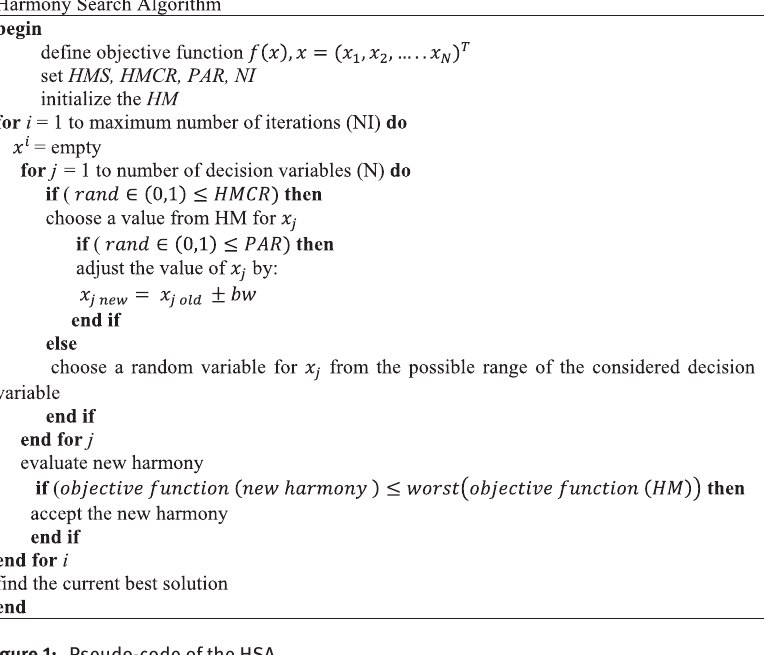
Figure 1: Pseudo-code of the